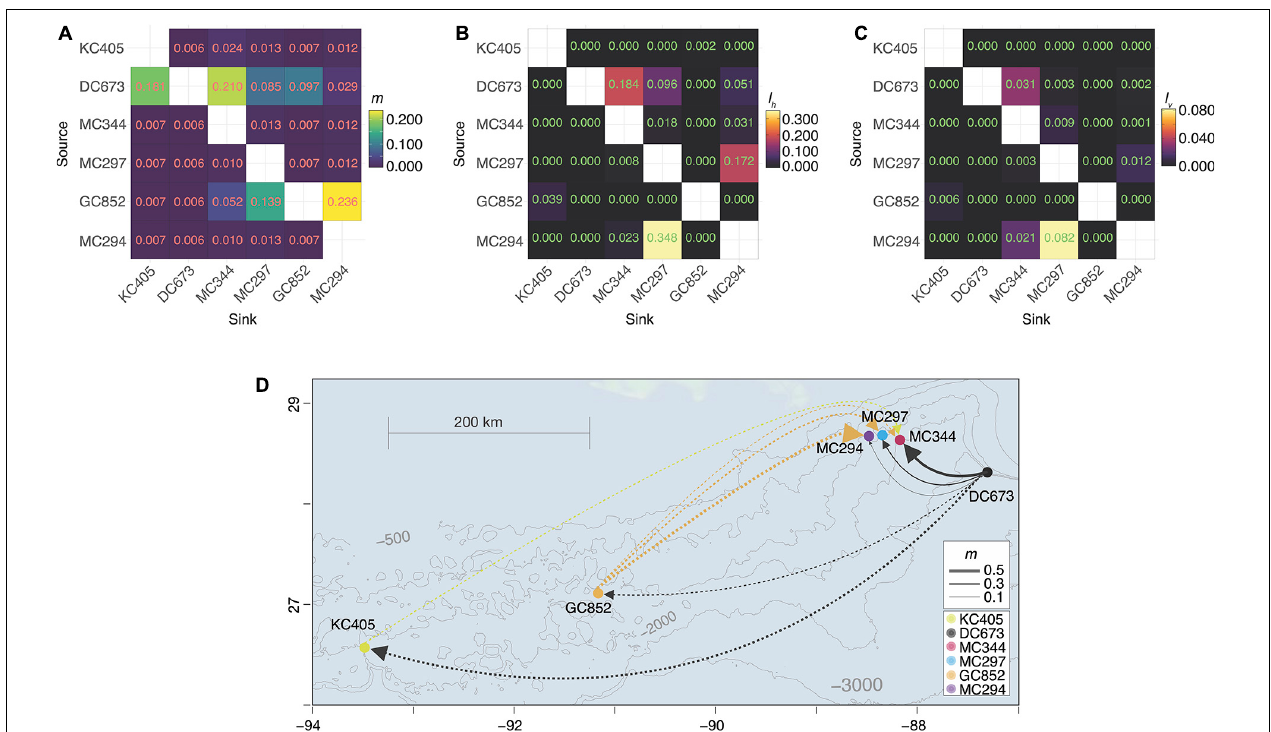
FIGURE 2 | Directional population connectivity Paramuricea biscaya in the northern Gulf of Mexico. (A) Migration rates ( m ) inferred from observed genetic data using BAYESASS. (B) Horizontal connectivity probabilities ( l h ) integrated over all available periods (56 days in February, April, and August releases, and 148 days for November) calculated from larval dispersal simulations. (C) 3D connectivity probabilities ( l v ) (including both horizontal and vertical components) calculated from larval dispersal simulations. Rows in each matrix indicate source sites, and columns indicate sink sites. (B,C) Are modified from Liu et al. (2021). (D) Map depicting population connectivity patterns among study sites. Dots indicate sites. A line connecting two dots indicates an observed (genetic) or predicted (model) connection > 0. Solid lines indicate connections supported by both genetic and model data. Dashed lines indicate connections supported only by genetic data. Arrowheads indicate the direction of the connection. Line thickness is proportional to the strength of the connection (measured as migration rate m ). Line and dot colors indicate site identities and correspond to those in Figures 1A,D